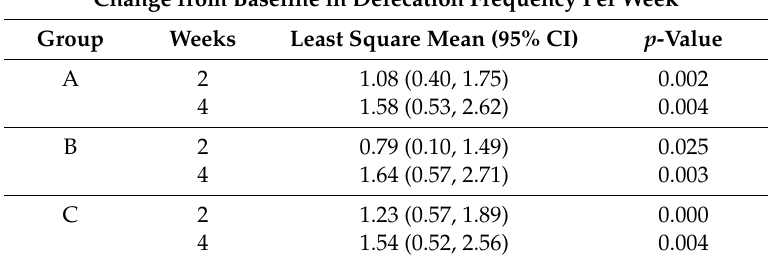
Table 2. Least square mean. The least mean square value is estimated by the linear mixed model, 95% confidence interval (95% CI), and p -value. In the t-test, the error is estimated by the linear mixed model. The null hypothesis was subjected to a two-sided test. Group A: Lactobacillus reuteri DSM 17938; group B: combination; group C: magnesium oxide.